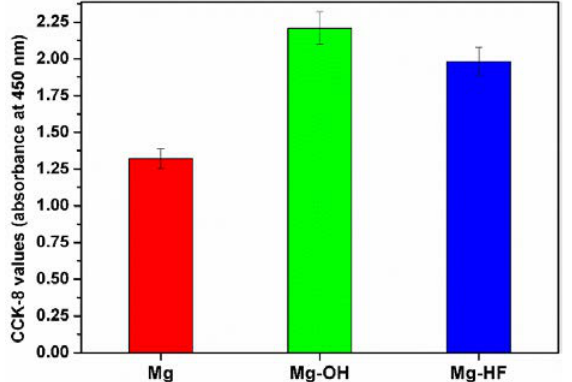
Figure 9. Endothelial cell proliferation characterized by CCK-8 assay for different samples. Data for each sample were taken from three parallel samples, and are expressed as mean ± SD. The absorbance values of the modified samples are significantly larger ( p < 0.05) than that of the pristine magnesium alloy.